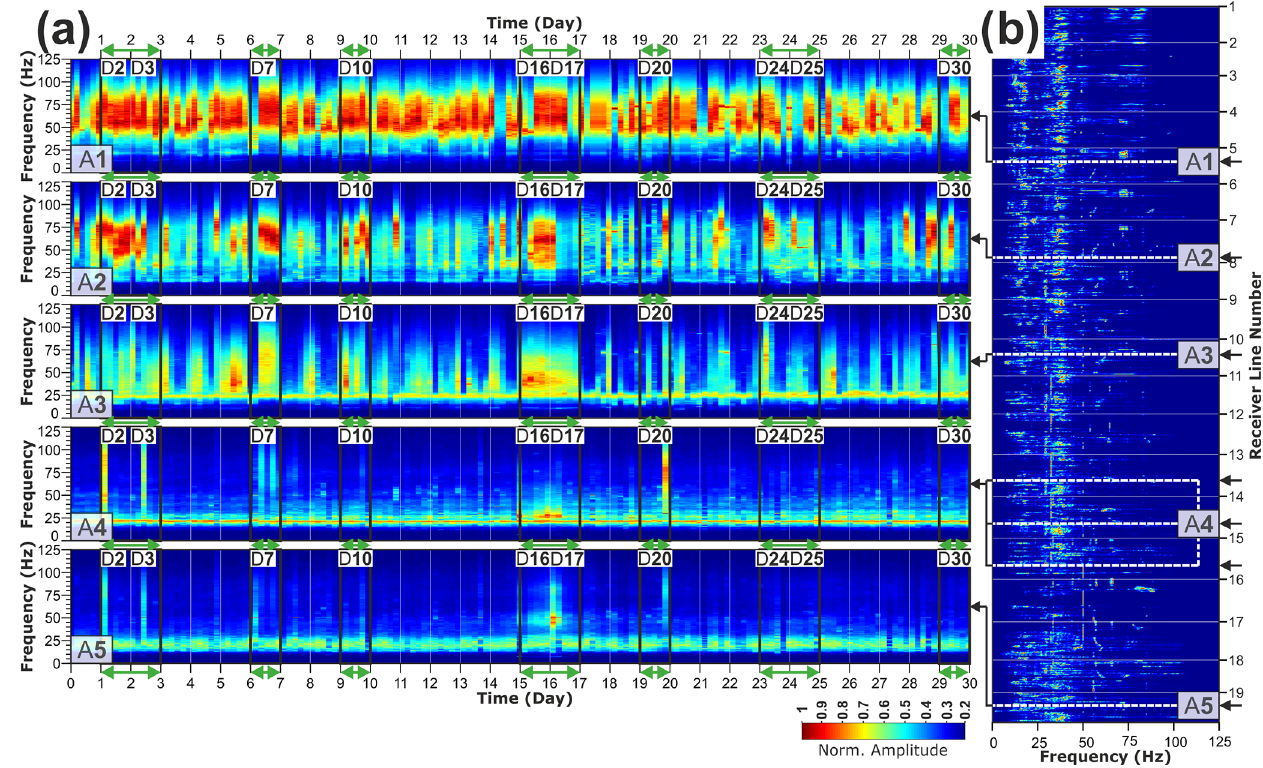
Figure 3. Temporal (a) and spatial (b) variation of noise spectrograms. (a) Each panel represents power spectral densities (PSDs) computed for each day of recording using receiver stations located in the representative areas highlighted in Fig. 1. Days highlighted with green arrows correspond to beamforming panels highlighted with green circles in Fig. 4a. (b) PSD for a single day of recording using every receiver station of the Kylylahti array. White dashed lines highlight receiver stations corresponding to the representative areas shown in (a) . Amplitudes are independently normalized in each panel. Two regimes of high power density are observed at frequency ranges of 10–30 and